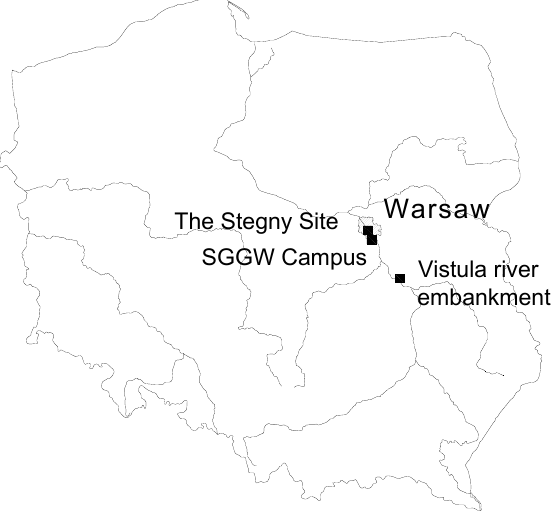
Figure 1. Location map of the test sites.